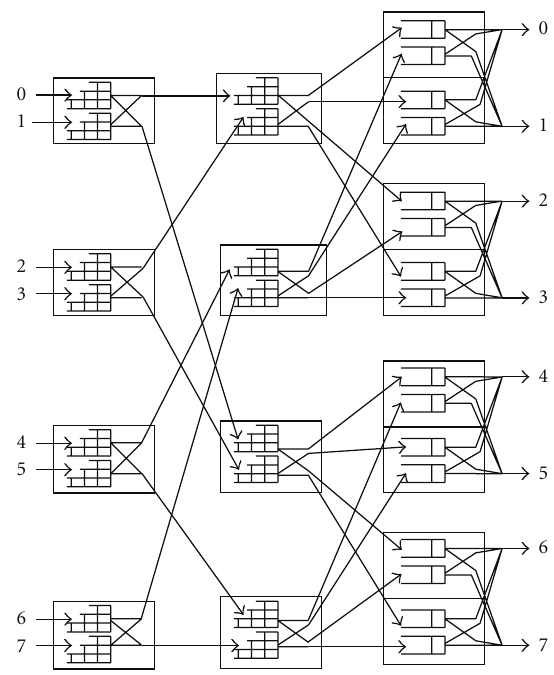
Figure 1: An 8 × 8 Delta Network with an asymetric segment (first two stages) and a multi-layer segment (last